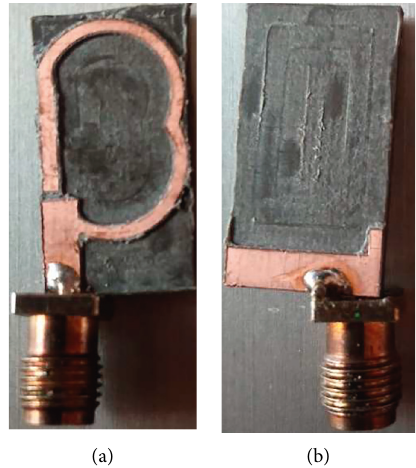
Figure 4: The proposed antenna (a) Top-view (b)